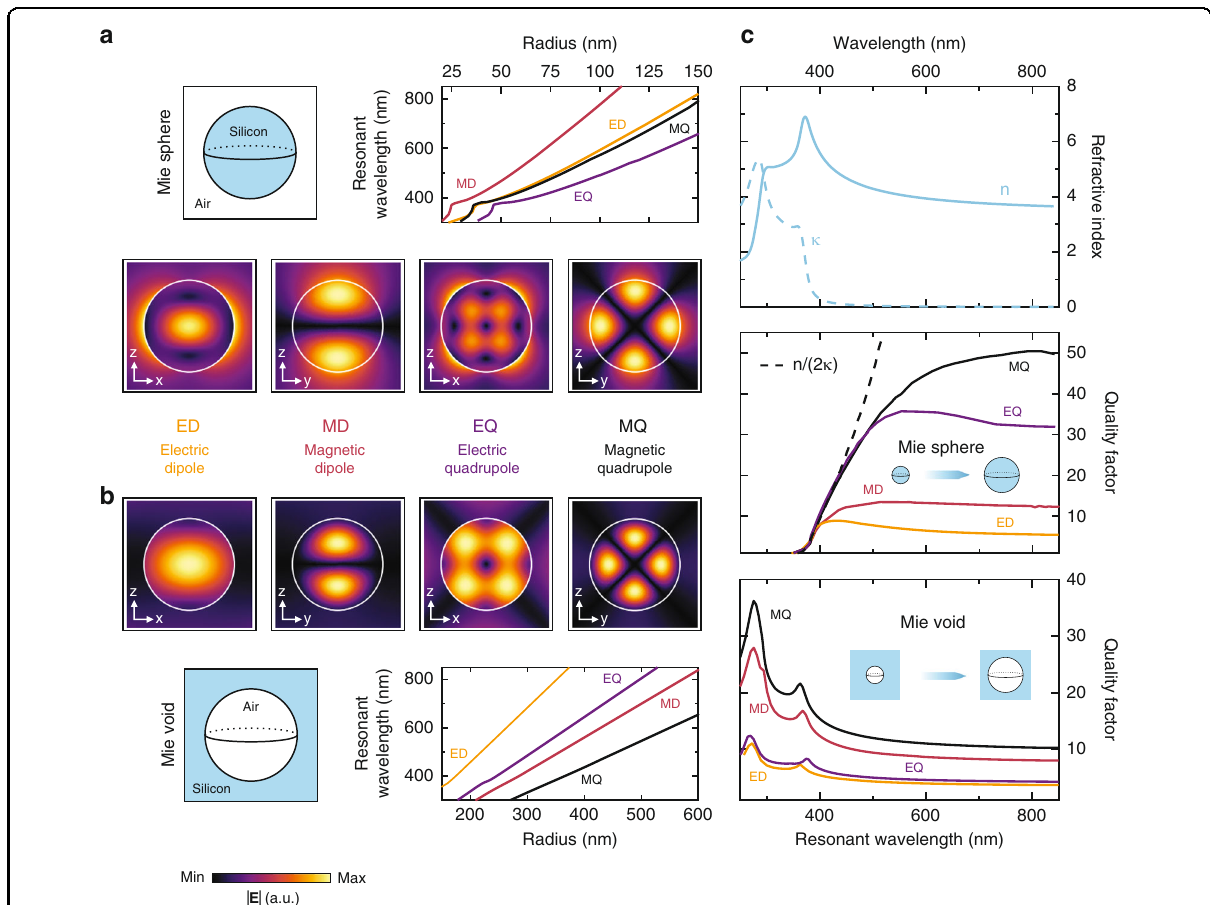
Fig. 2 Mie ’ s theory for silicon particles in air and air voids in Si. a Field pro fi les and dispersion relations for localized Mie modes of a solid silicon Mie sphere in air and b , of a Mie void, which is, a spherical void inside an isotropic silicon environment. In both cases, Mie theory predicts the existence of localized modes (electric and magnetic dipole as well as quadrupole and higher-order modes). In spite of the inversed geometry, the modes show strong resemblance, yet, differ in the degree of con fi nement to the silicon and air, respectively. The dispersion relation of the modes of the silicon sphere is strongly in fl uenced by the spectral dependence of the silicon refractive index and absorption (see c ). For the Mie voids, in contrast, we observe perfectly linear dispersion, showing that the modes are fully localized in air without any noticeable in fl uence of the silicon dispersion. c Real part n and imaginary part κ of the refractive index of silicon (upper panel) in comparison to the properties of the sphere and void modes (middle and lower panel, respectively) 64 . The graphs show the quality factors of each of the four fundamental modes for the sphere and void vs. the resonant wavelength of each of these modes. The dependence of the quality factor on the resonant wavelength is calculated by sweeping the sphere and void size. In case of the sphere (middle panel), one observes a drastic reduction of the quality factor for resonant wavelength approaching 400 nm and no modes are observed for wavelengths < 380 nm. This behaviour can be explained by the material losses in silicon, depicted with a dashed line showing the material quality factor n = 2 k . In case of the void (lower panel) the modes are con fi ned within the air void. Consequently, the losses in silicon do not lead to a damping of the modes but rather result in a stronger con fi nement of the mode in the void by virtue of increased Fresnel re fl ection coef fi cient at the air-silicon interface (increased refractive index and increased absorption). Consequently, one can excite strongly con fi ned modes in the deep-blue and UV spectral ranges with quality factors up to